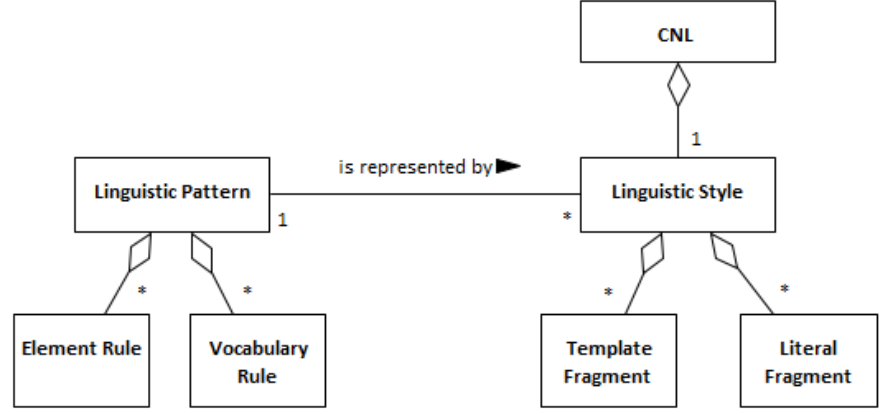
Figure 3. Relation between linguistic pattern and linguistic style (UML